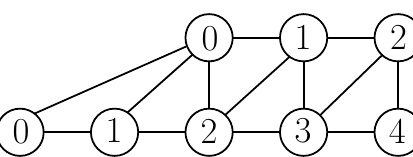
Figure 14. Dual diagram representing the U(4 j 2; (cid:9)) Kac-Moody algebra. In this picture, the di(cid:11)erent orderings of (cid:12)ve-branes coming from the left and right correspond to di(cid:11)erent triangulations of the